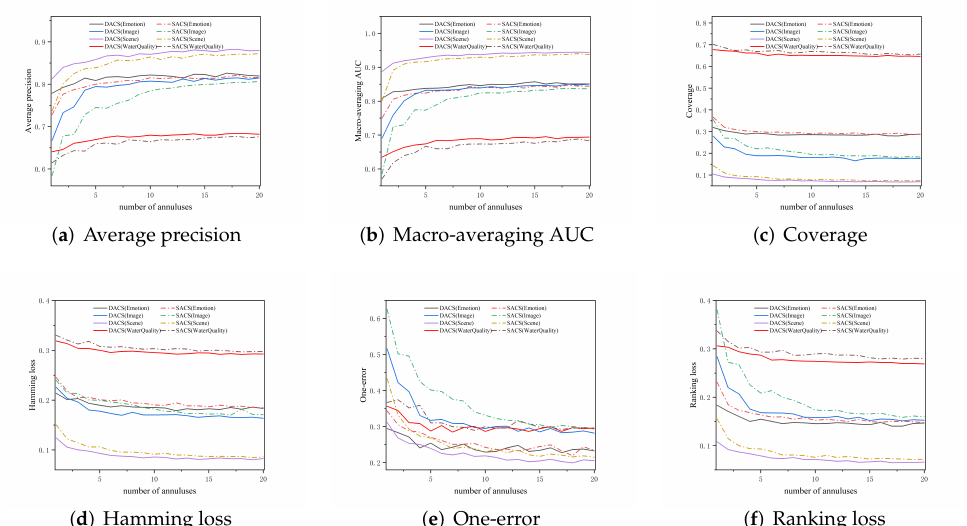
Figure 6. Comparison of DEPT and SCFS in terms of each evaluation metric as the parameter annulus increases from 1 to 20 on 4 benchmark multi-label data